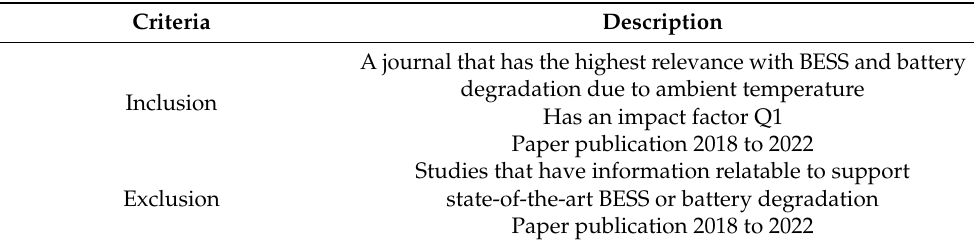
Table 2. Criteria for the systematic literature